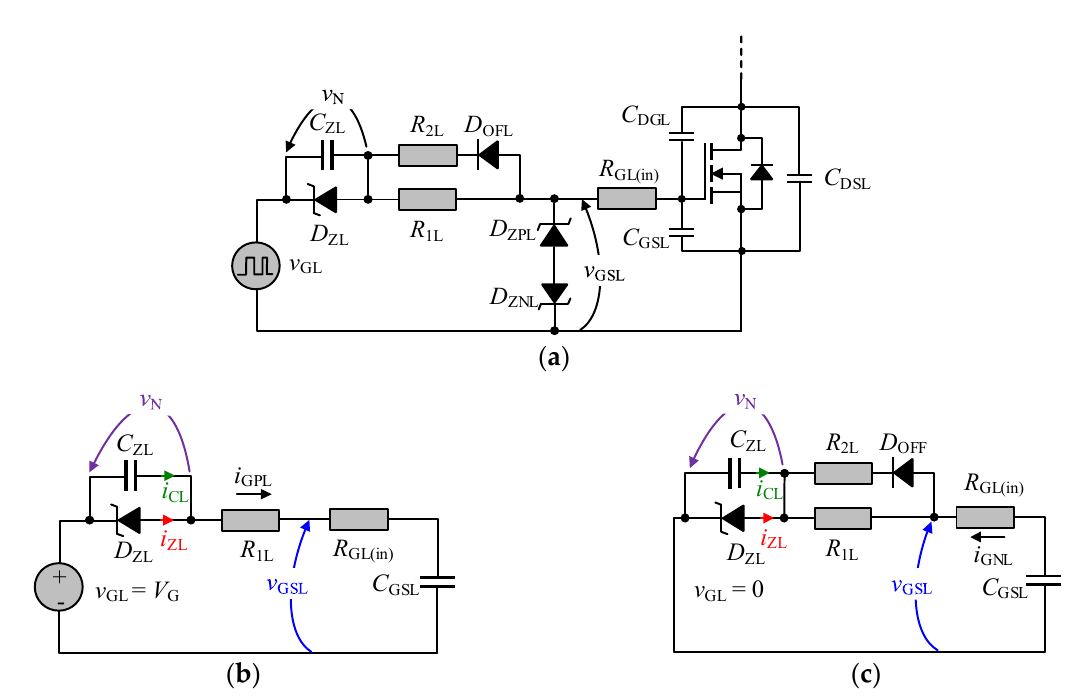
Figure 3. ( a ) The proposed gate driver for SiC MOSFET, and equivalent circuits during ( b ) turning-on transition and ( c ) turning-off.